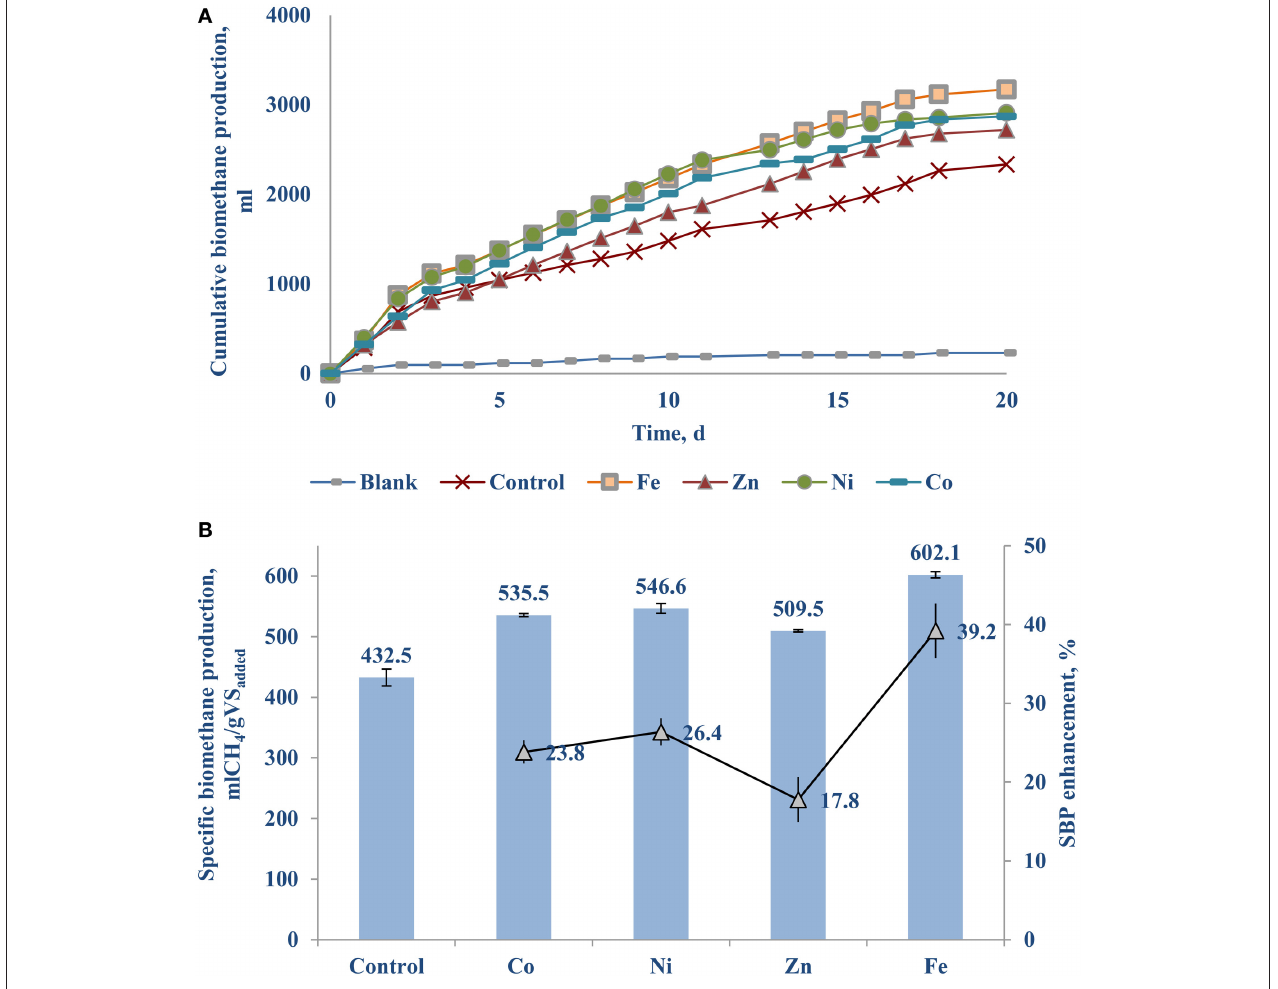
FIGURE 3 | The individual effect of Fe, Zn, Ni, and Co on the BMP of FW-A: (A) Cumulative methane curves; and (B)